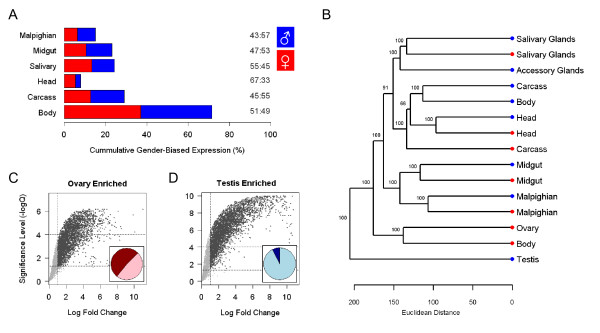
Sexually dimorphic expression. (A) The proportion of sexually dimorphic expression in each tissue versus total sexual dimorphism. The ratio of female- to male-biased expression is provided (female:male). All ratios deviate significantly from equality (Chi-squared test; P < 0.05). (B) Hierarchical clustering of probes among tissues and sex with Euclidean Distance; female (red), male (blue). Branch support was estimated with 10,000 bootstrapped replicates. Expression enrichment against carcass for the (C) ovary and (D) testis. Significant gonad enrichment is highlighted in dark grey (ANOVA; M > 2; Q < 0.05). Inset figures show the proportion of gonad enrichment which is also sexually dimorphic in whole-body samples, i.e. 51% female-biased (dark red); 7% male-biased expression (dark blue).